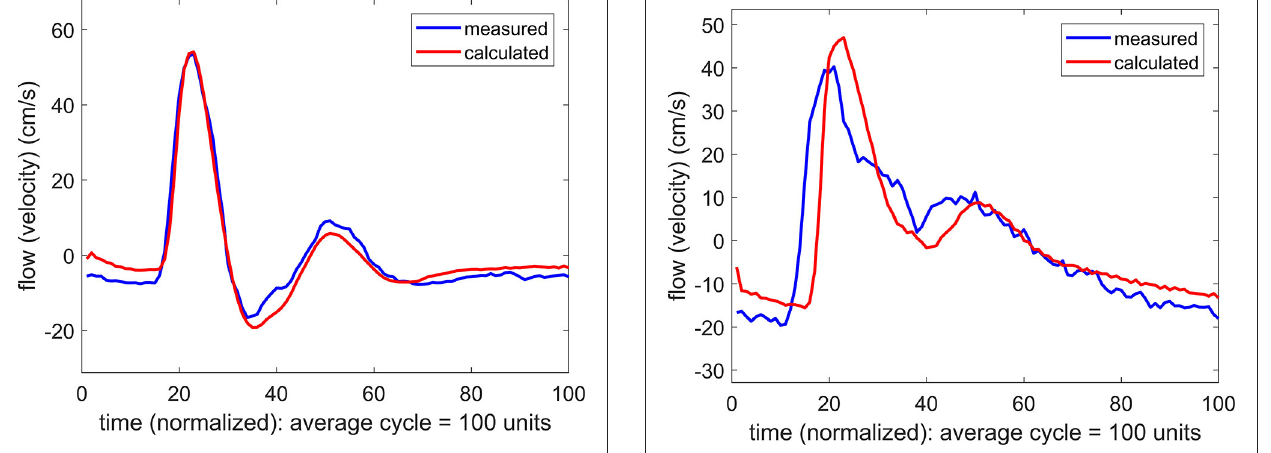
FIGURE 3 | Comparison of measured and calculated flow (velocity) waveforms in the cerebral vascular bed, the latter being based on systemic pressure waveform measured simultaneously at the brachial